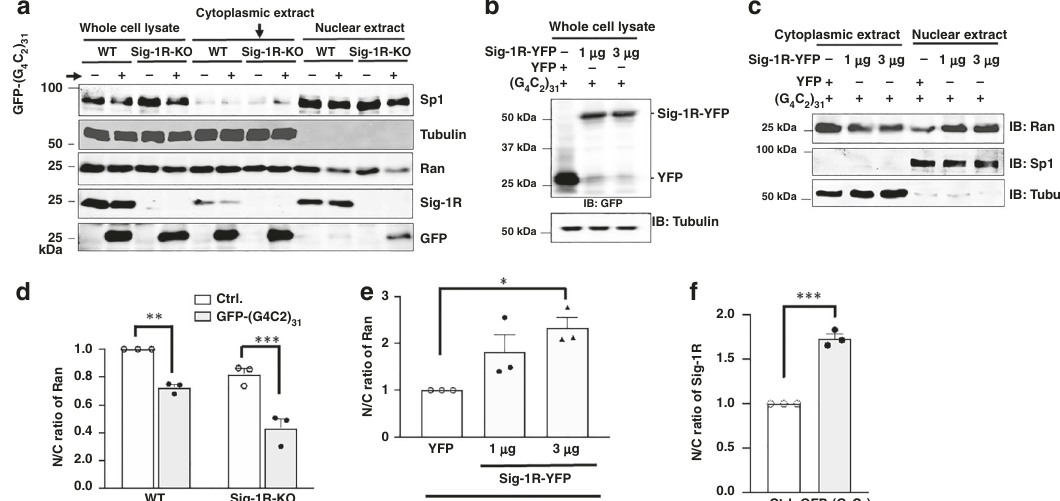
Fig. 7 Sig-1R knockout exacerbates whereas Sig-1R overexpression attenuates the cytoplasmic Ran accumulation caused by (G4C2) 31 -RNA: western blot analyses. a Apparent decrease of nuclear Ran in Sig-1R knockout cells when compared to that seen in wild-type cells. Subcellular fractionation followed by western blot was used to examine the level of Ran in the cytoplasm or nucleus in HeLa cells in which Sig-1Rs were depleted by the CRISPR/ Cas9 technique. GFP-(G 4 C 2 ) 31 vectors were transiently transfected for 24 h into either wild-type or CRISPR/Cas9 Sig1R-KO cells before subcellular fractionation. b Sig-1R successfully overexpressed in (G4C2)31-RNA-treated cells. c Overexpression of Sig-1R decreased Ran in the cytoplasm while concomitantly increased Ran in the nucleus. d Sig-1R knockout apparently exacerbates the N/C ratio of Ran when compared to that seen in wild type. See Results for explanations. Quantitative summary of results from three sets of independent experiments illustrated in a . Data are presented as means ± SEM; n = 3 for each group; two-way ANOVA followed by Sidak ’ s multiple comparisons test, p = 0.0027 for wild-type group, p = 0.0003 for Sig-1R-KO group, ** p < 0.01; *** p < 0.001. e Overexpression of Sig - 1Rs signi fi cantly rescues the aberrant N/C ratio of Ran caused by the (G4C2) 31 -RNA. Quantitative summary of results from three sets of independent experiments illustrated in c . Data are presented as means ± SEM; n = 3 for each group; one-way ANOVA followed by Sidak ’ s multiple comparisons test, p = 0.172 for YFP vs 1 μ g, p = 0.0276 for YFP vs 3 μ g, p = 0.4723 for 1 μ g vs 3 μ g, * p < 0.05. f Increase of nuclear Sig-1Rs in the (G4C2) 31 -RNA-treated HeLa cells. Quantitative summary of results from three sets of independent experiments illustrated in a . Data are presented as means± SEM; n = 3 in each group. Two-tailed unpaired Student ’ s t test ( p = 0.0001), *** p < 0.001. Note: the N/C ratio of the control in each independent experiment in d – f was taken as one. The N/C ratio from each experiment was normalized to respective control. Sig-1R: Sigma-1 receptor; Ran: ras-related nuclear protein. n = 3 ( a ), n = 3 ( b ), and n = 3 ( c ) independent experiments with similar results from biologically independent cellular